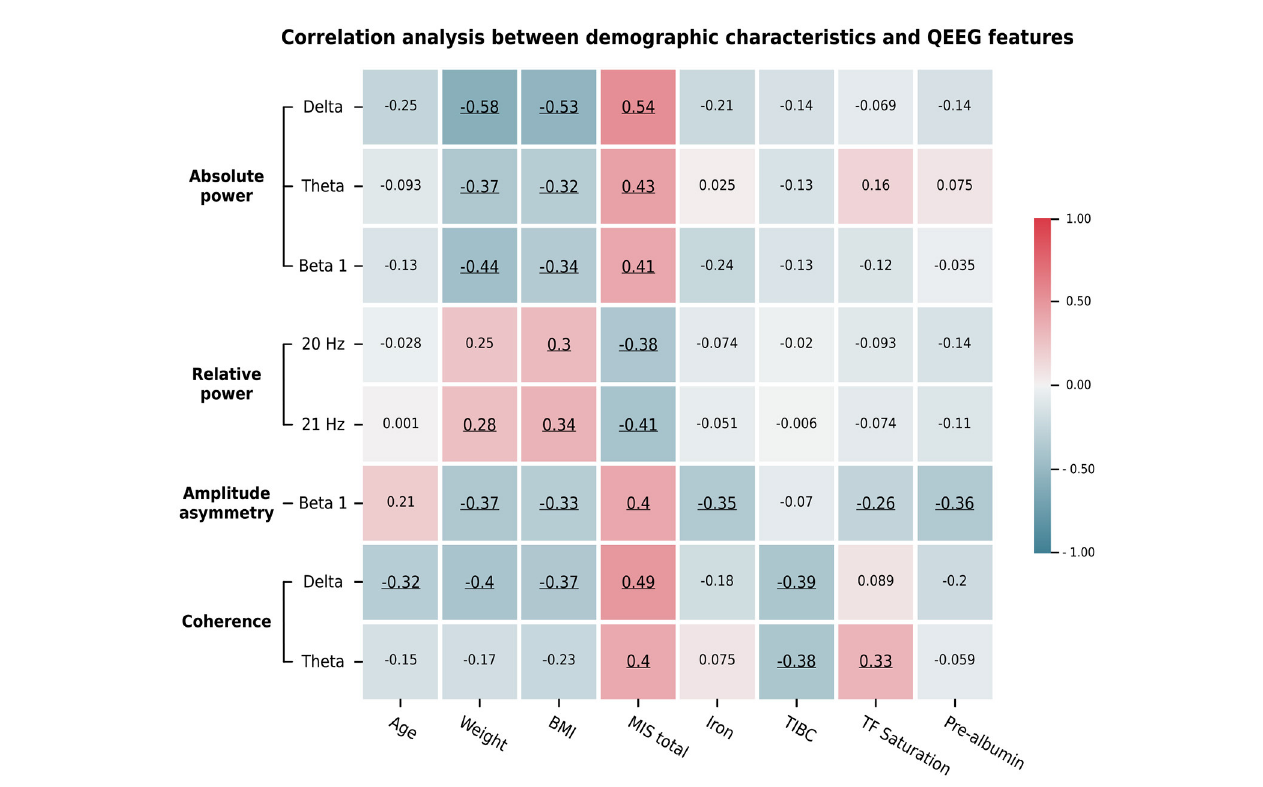
FIGURE5 The average Z-scores of the significant QEEG features assessed by channel-wise and channel pair comparisons determined by significant correlations with the total MIS score and other demographic data. Pearson’s and Spearman’s rank correlation coefficients were calculated based on the data types. Their values are represented by the color bar. Only significant correlations ( p < 0.05) are